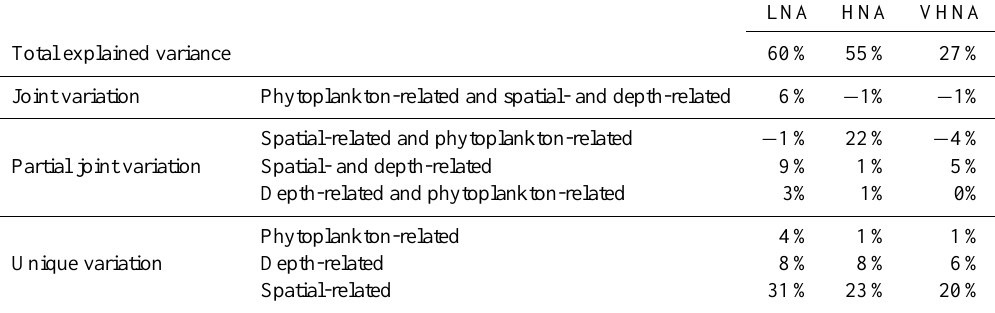
Table 4. Partial redundancy analysis performed on each heterotrophic prokaryote cluster optically resolved by flow cytometry: low nucleic acid content (LNA), high nucleic acid content (HNA) and very high nucleic acid content (VHNA). According to the PCA results, Chl a and silicic acid are the phytoplankton-related variables. Temperature and salinity are the spatial-related variables. Nitrate, phosphate and depth are the depth-related variables. Negative values characterized the lack of any correlation between heterotrophic prokaryote clusters and the variables tested. LNA Total explained